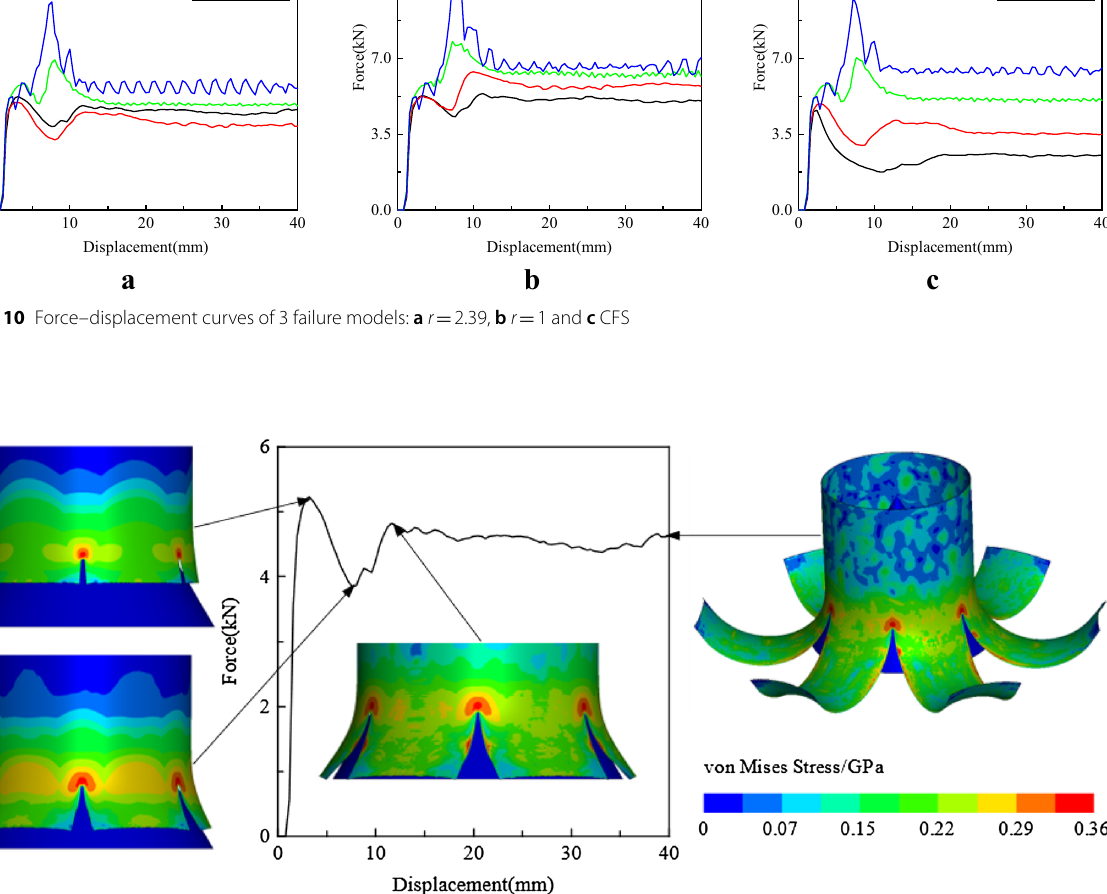
Figure 11 The axially splitting process of the circular tubular